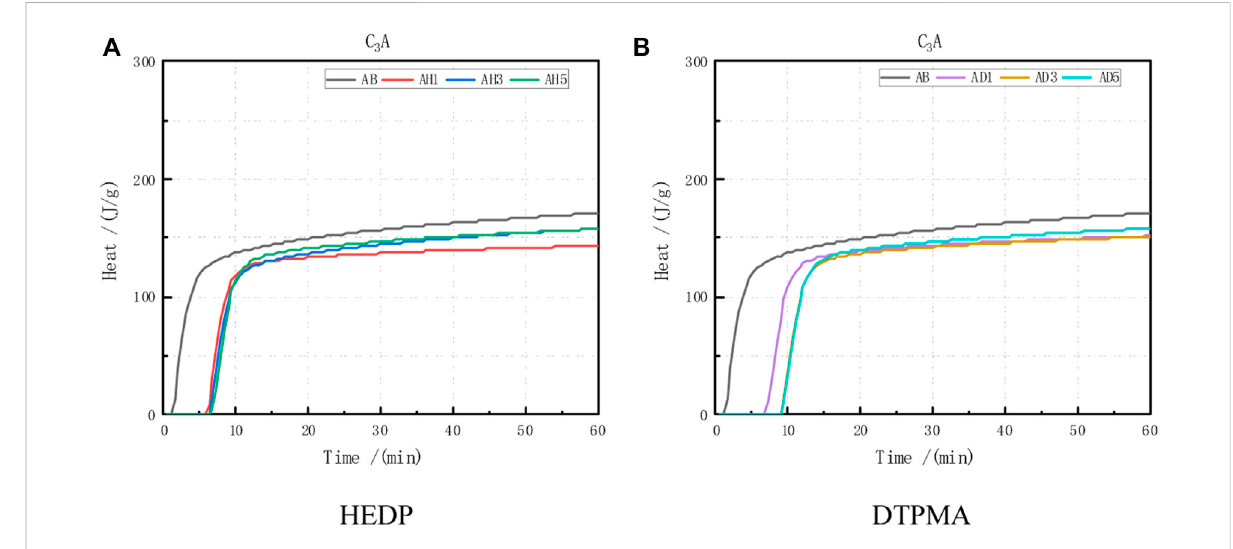
FIGURE 6 Heat of hydration data obtained from C 3 A combined with the following: (A) HEDP and (B) DTPMA.